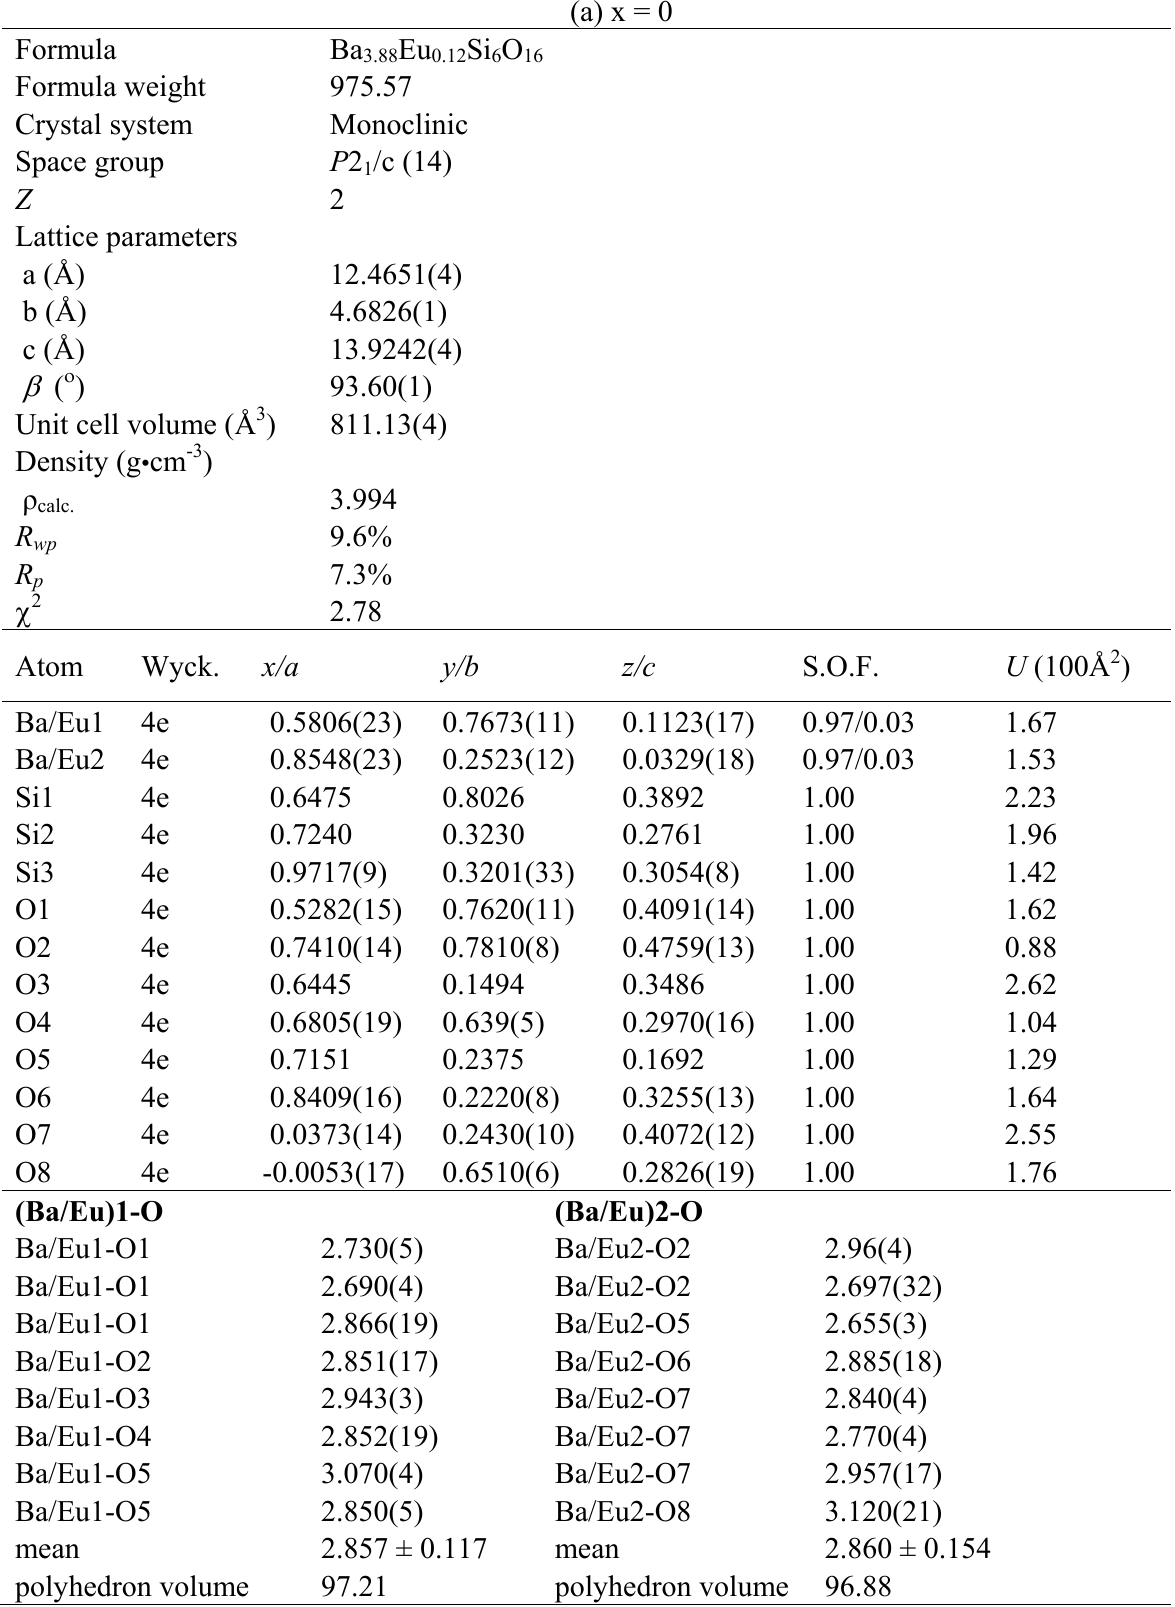
for Ba Eu Si O N , (a) x = 0, Eu 3.88 0.12 6 16-3x/2 x